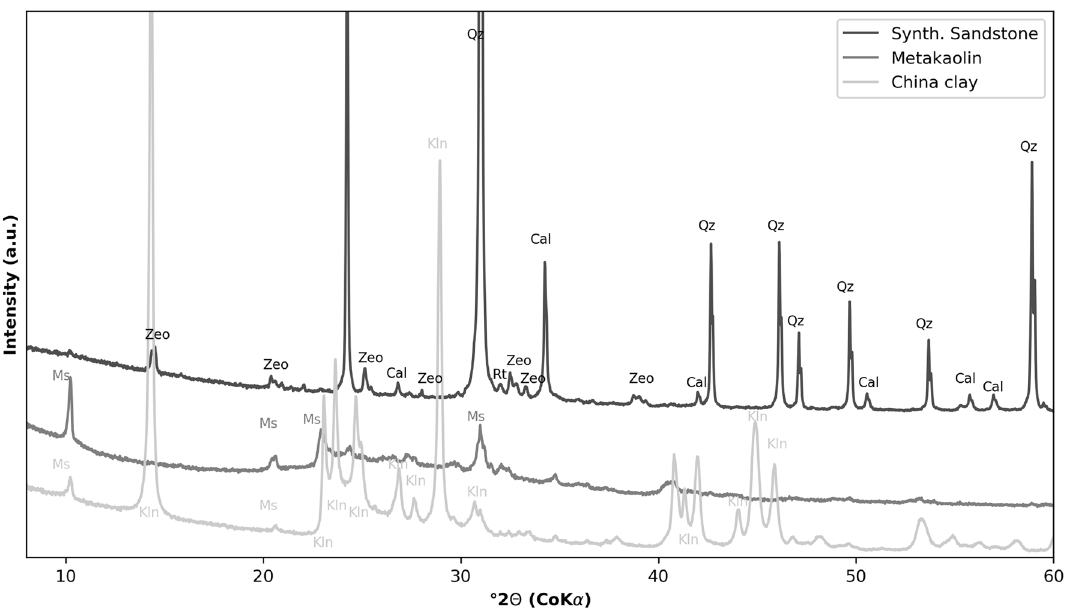
Fig. 2 X-ray diffraction patterns of the initial China clay, metakaolin after heating at 600 °C for 2 h and the micronised synthetic sandstone. ( Ms muscovite, Kln kaolinite, Qz quartz, Cal calcite, Zeo zeolite, a.u. arbitrary